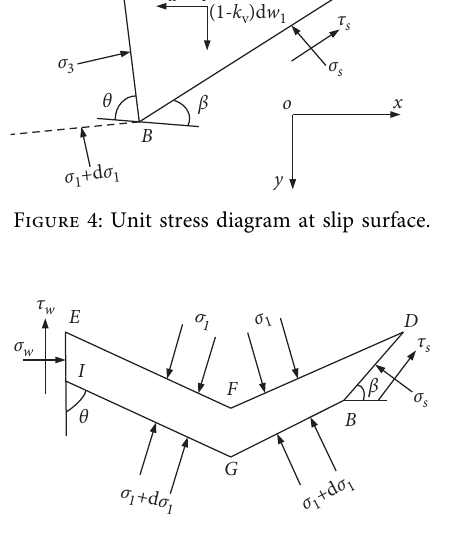
Figure 5: Force analysis diagram of